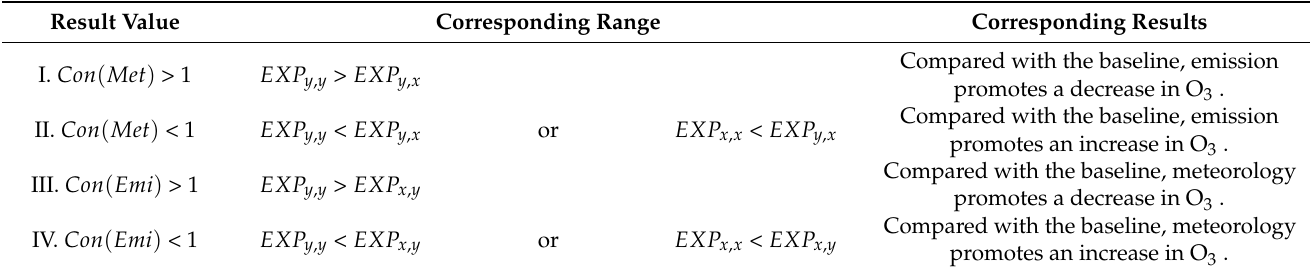
Table 3. Sensitivity contribution results and corresponding meteorological